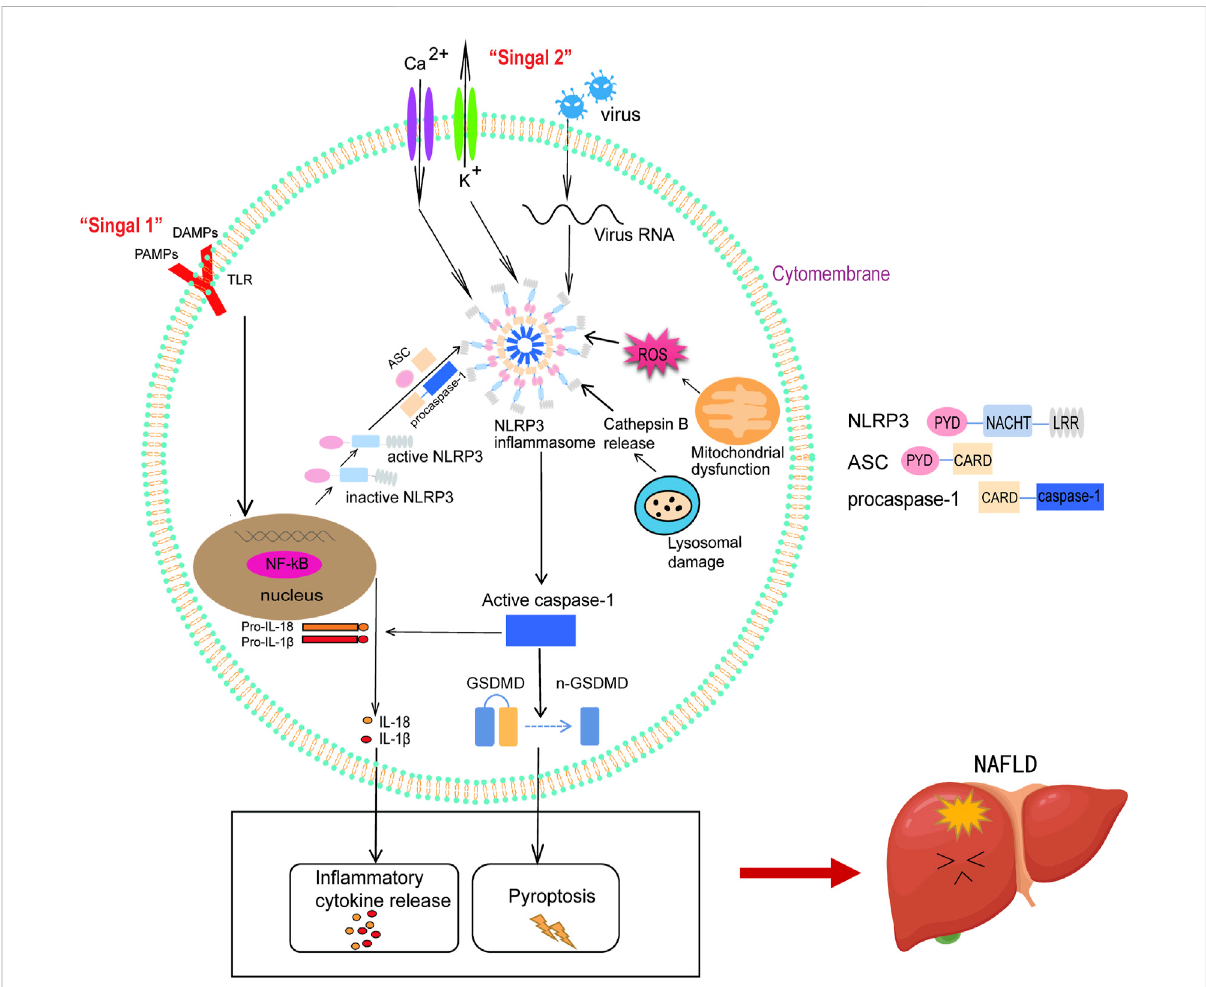
FIGURE 1 Activation of NLRP3 in fl ammasome mediates the development of NAFLD. The activation of NLRP3 in fl ammasome includes initiation and activation steps. During the initiation step, TLR is stimulated by extracellular signalling molecules, leading to NF- κ B activation, which activates NLRP3 and promotes the expression of pro-IL-1 β and pro-IL-18 (Signal 1). During the activation step, stimulation such as K + out fl ow accompanied Ca 2+ in fl ux, ROS release, mitochondrial dysfunction, and lysosome damage induce the assembly of NLRP3 in fl ammasome (Signal 2). After NLRP3 in fl ammasome activation, activated caspase-1 converts pro-IL-1 β and pro-IL-18 into mature IL-1 β and IL-18, leading to the release of in fl ammatory cytokines. Activated caspase-1 dissociates GSDMD, releases its N-terminal, and forms pores in the plasma membrane, stimulating the occurrence of pyroptosis. The interaction between in fl ammatory factors and pyroptosis induces the in fl ammatory fi brosis microenvironment in the liver and promotes the occurrence and development of